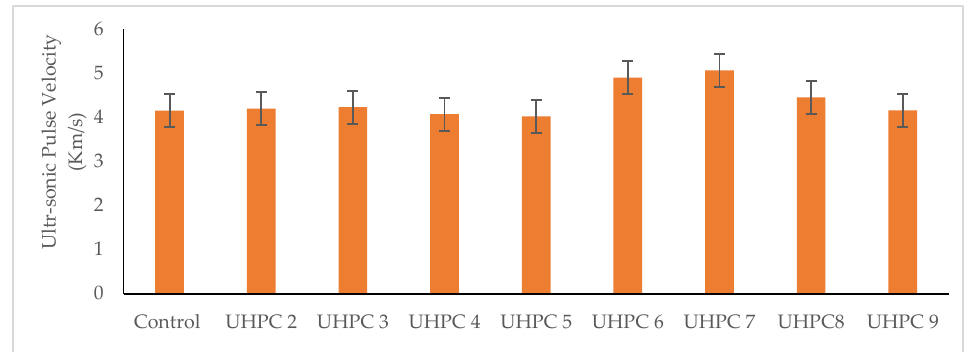
Figure 8. Ultrasonic pulse velocity after 90 days for glass and lime powder replacement ratios.